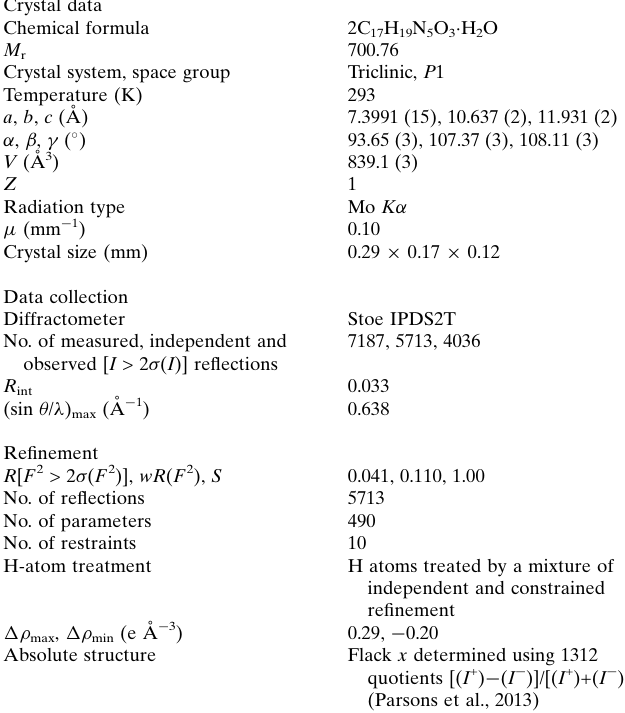
Table 2 Experimental details. Crystal data Chemical